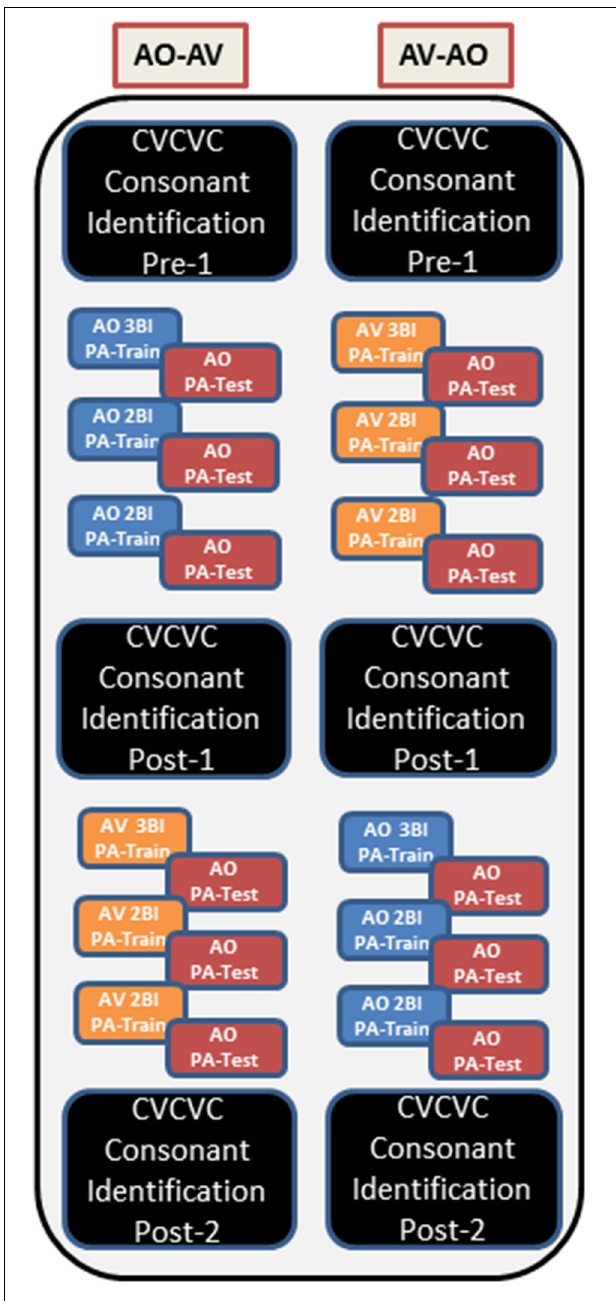
FIGURE 1 | Overall design of Experiments 1 and 2. The left column corresponds to the AO-AV modality assignment, and the right column corresponds to the AV-AO modality assignment. Within each assignment thereweresixtraininglists,threewithAVstimuliandthreewithAO.Thefirst list in each modality was trained for three blocks (Bl), and the subsequent two lists were trained for two blocks. At pre-1, post-1, and post-2 times, CVCVC consonant identification was tested using untrained